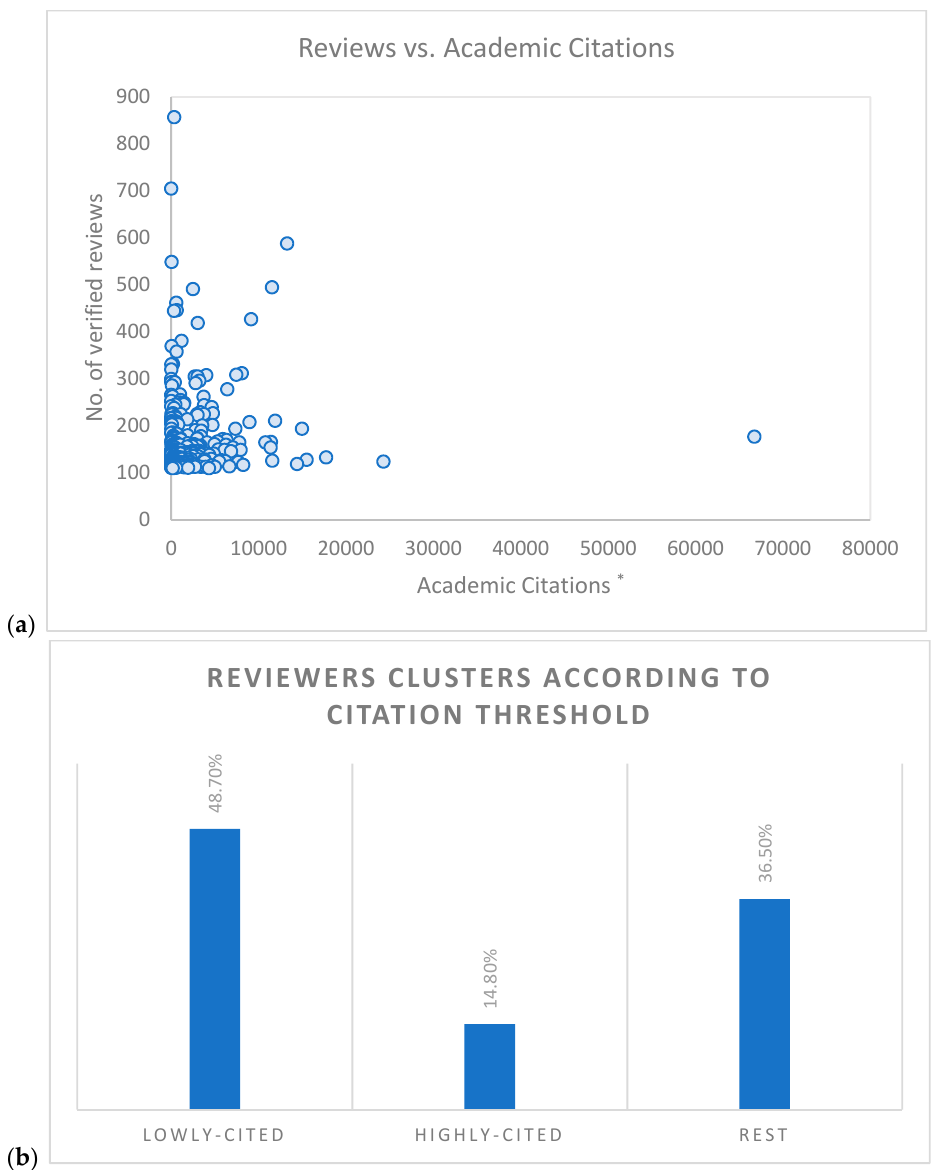
Figure 1. ( a ) Verified reviews in the last 12 months vs. academic citations for the sample analysed (as of 18 October 2018) * Citations have been sourced exclusively from Scopus through the open researcher and contributor ID (ORCID) on the Publons profiles. In those few cases where the ORCID did not return a positive match on Scopus we have searched for outputs in ORCID and in turn searched for those outputs on Scopus to identify the academic and gather their citations. ( b ) Contribution to the sample of reviews analysed according to citation cluster. Lowly-cited reviewers are those with <999 citations, and highly-cited those with >5000 citations.